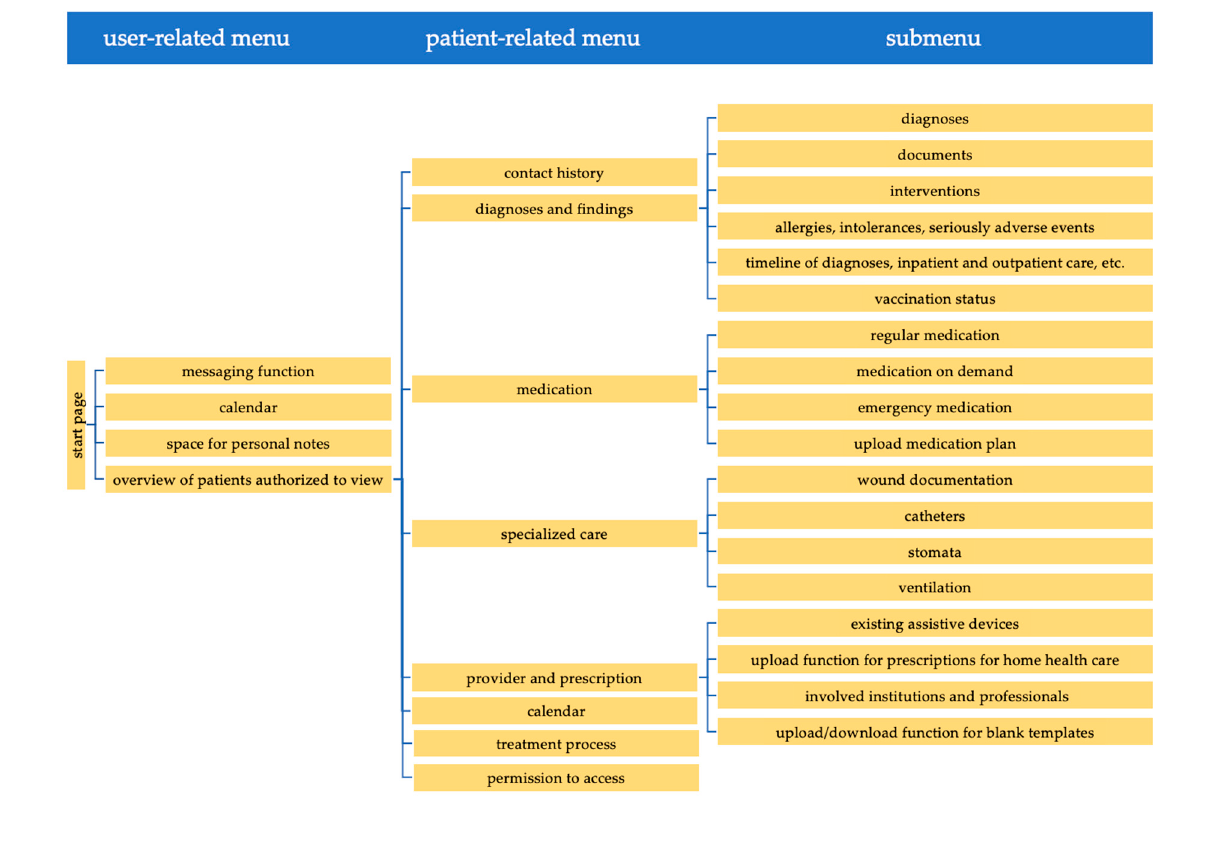
Figure 1. Structure of the ECHR system.